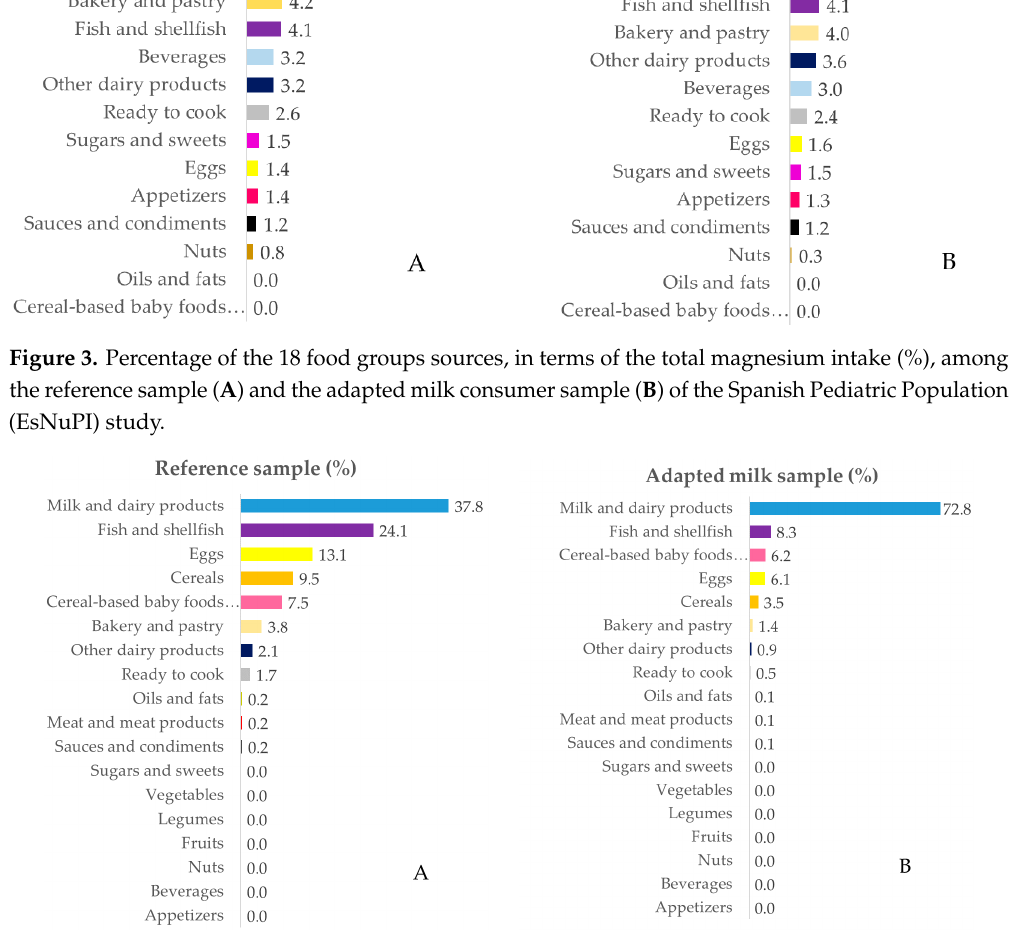
Figure 4. Percentage of the 18 food groups sources, in terms of the total vitamin D intake (%), among the reference sample ( A ) and the adapted milk consumer sample ( B ) of the Spanish Pediatric Population (EsNuPI) study.